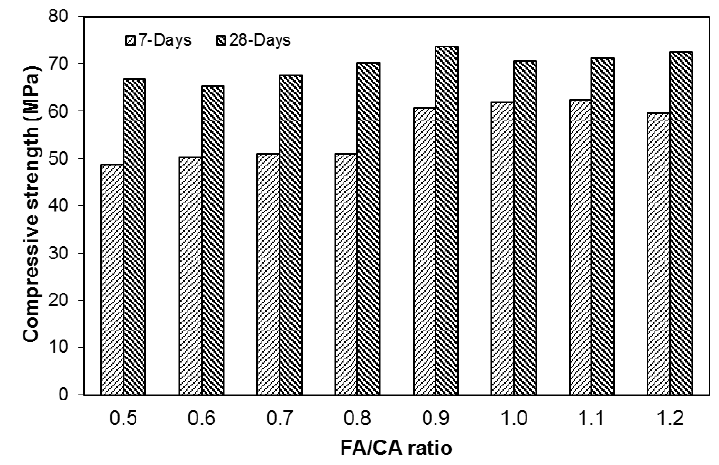
Figure 8. Compressive strength behavior of SFRC.